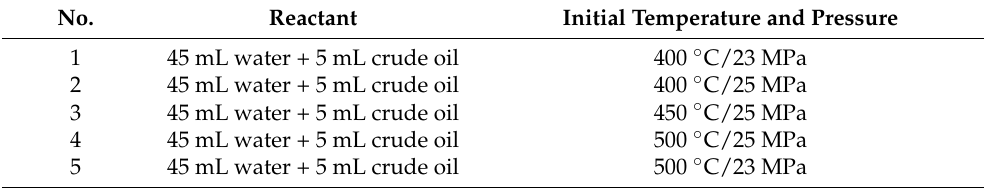
Table 4. Experimental parameters of supercritical water–crude oil reaction to generate supercritical multi-thermal fluids under different temperature and pressure conditions.